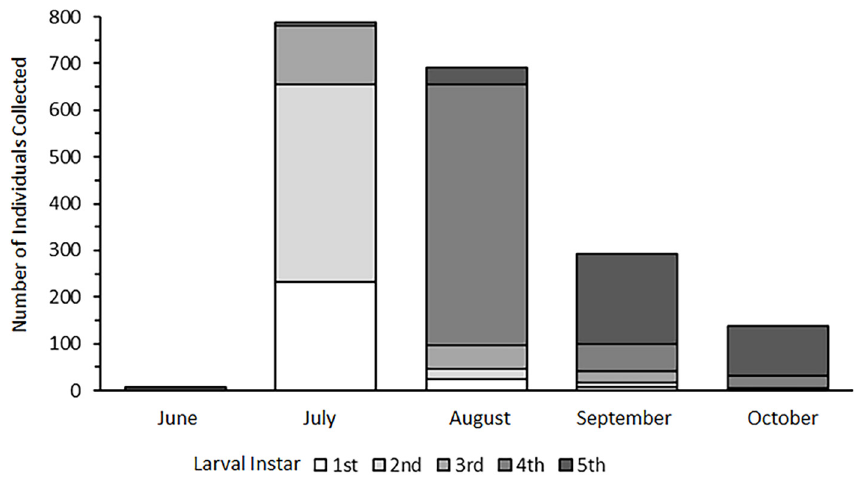
Figure 6. Stage-specific abundance data from introduced substrate sampling in Sites 1 and 2 during the open water season of 2020.